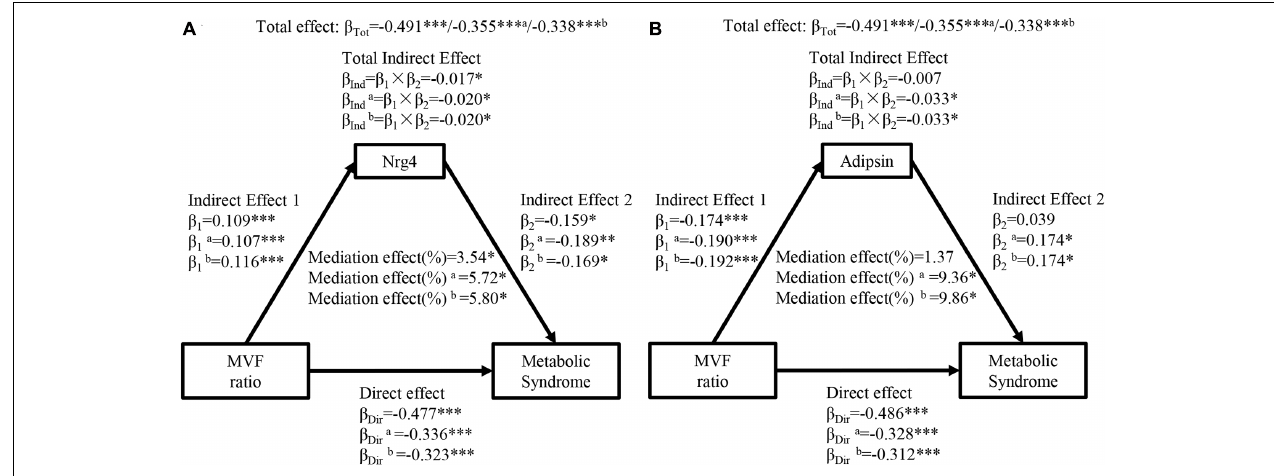
FIGURE 3 | Ngr 4 and adipsin mediate the effect of MVF ratio on metabolic syndrome. (A) Mediation analysis of Nrg4. (B) Mediation analysis of adipsin. β , standardized regression coefficient; β 1 , indirect effect 1; β 2 , indirect effect 2; β Ind , total indirect effect; β Dir , direct effect; β Tot , total effect; MVF, muscle mass to visceral fat; Nrg4, neuregulin 4. Model a: adjusted for fasting insulin, 2-h glucose. Model b: adjusted for model a + HOMA-IR. * P < 0.05; ** P < 0.01; *** P <